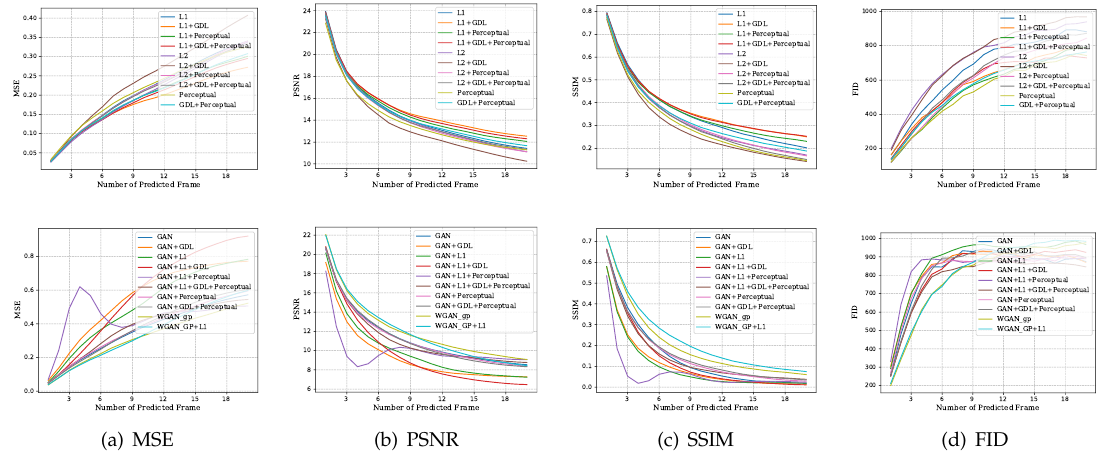
Figure A1. Mean values per predicted frame for the KITTI Tracking evaluation dataset. (MSE and FID: smaller values are better, PSNR and SSIM: larger values are